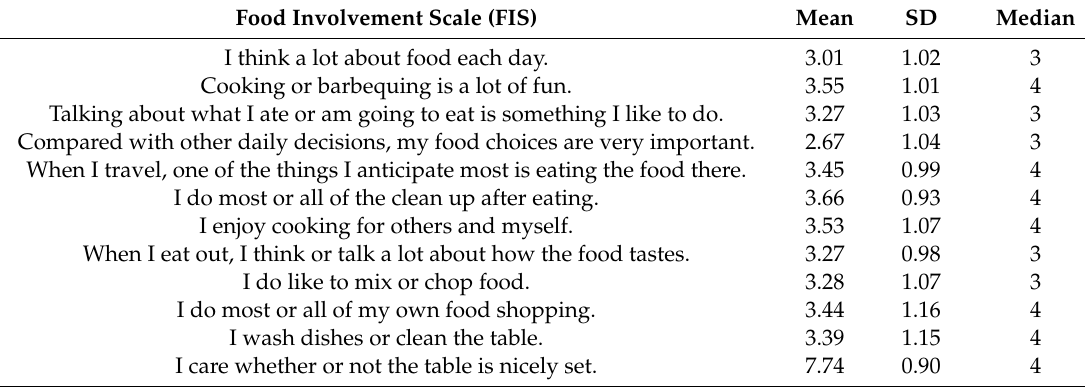
Table 3. Food Involvement Scale (FIS)